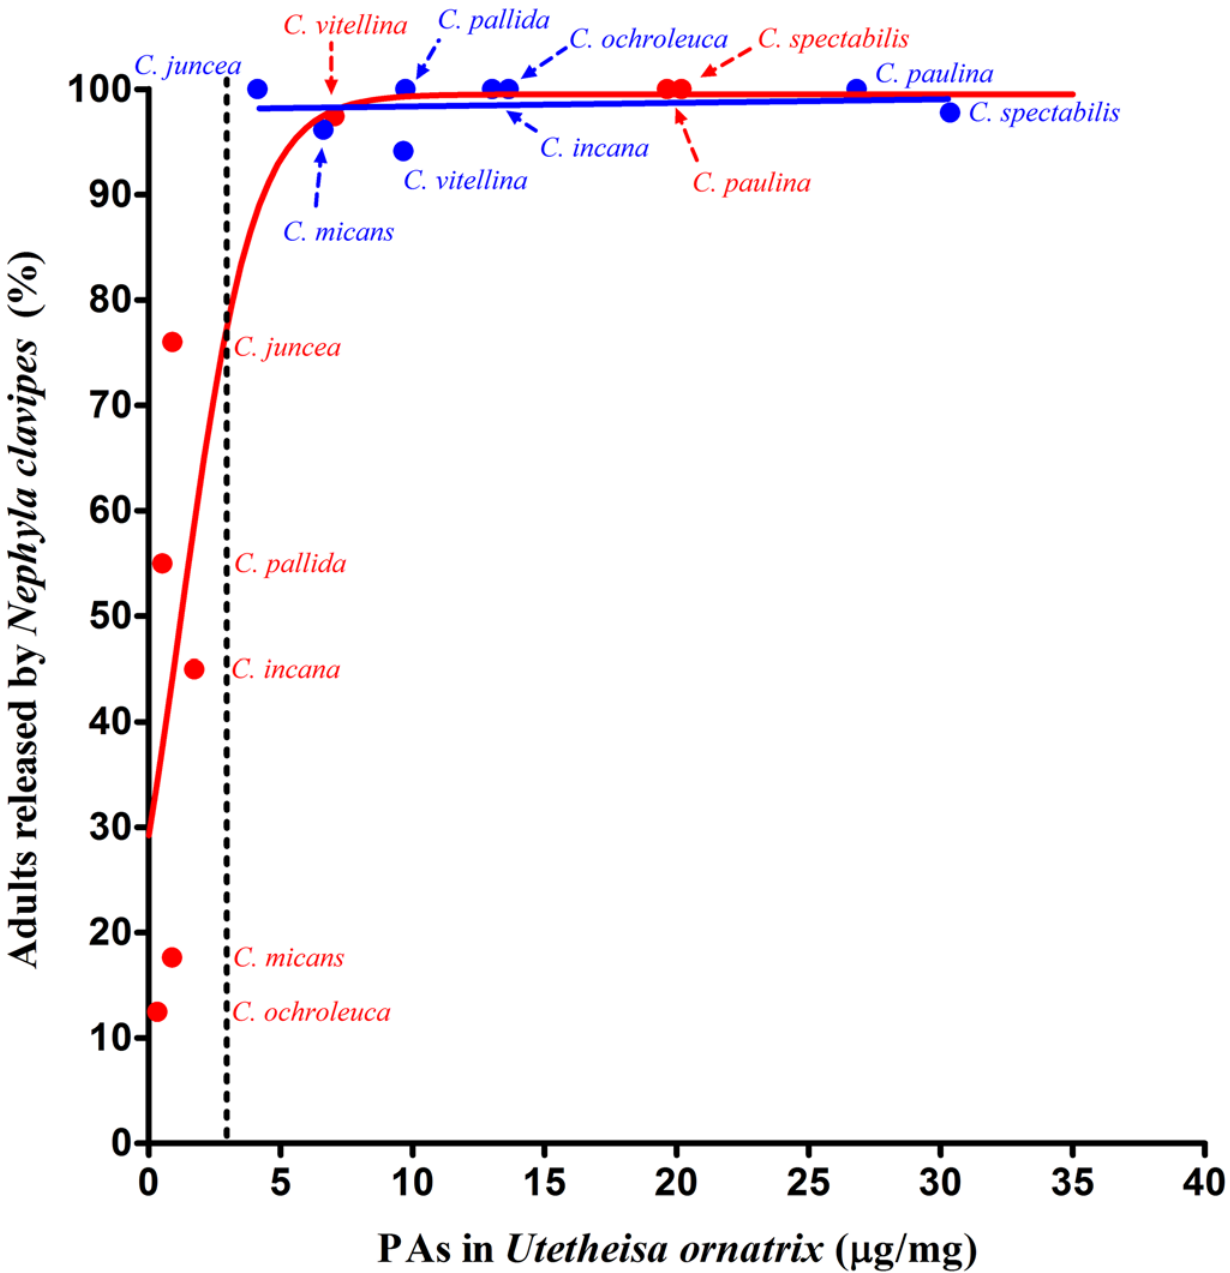
Fig 7. Non-linear relationship between the mean of pyrrolizidine alkaloid concentration ( μ g/mg dry weight) in adults of Utetheisa ornatrix fed on leaves of different Crotalaria species and the percentage of these adults released by Nephila clavipes . Red symbols stand for larvae fed on leaves and blue symbols stand for larvae fed on seeds. The dotted line is the concentration at which baits treated with monocrotaline and integerrimine in the N- oxide form (3.0 μ g/mg) were 100% released by Nephila clavipes